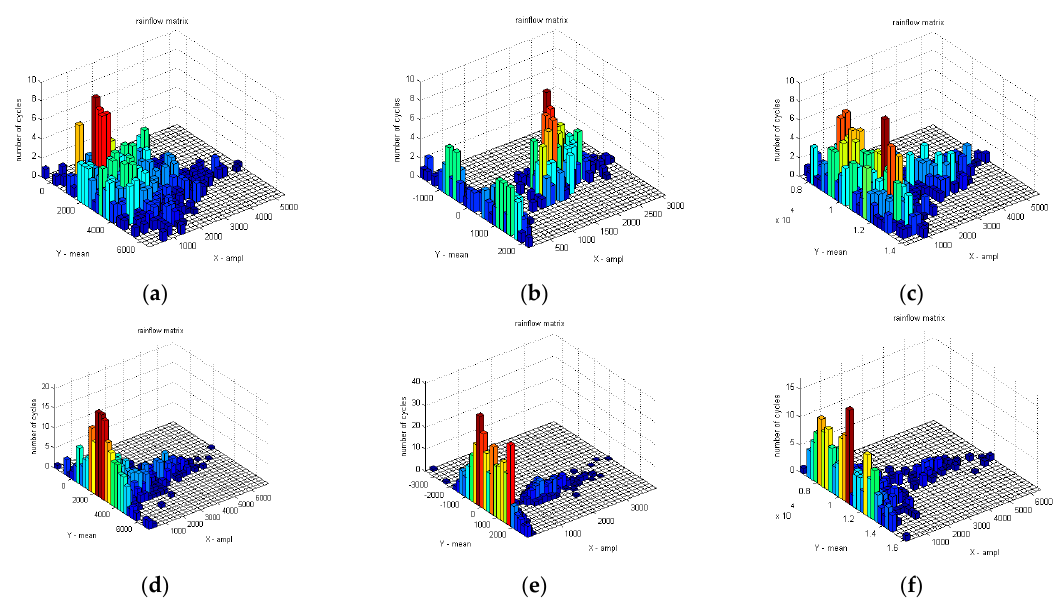
Figure 9. Rain flow matrix of load on the standard road. ( a ) Rain flow matrix of F x on the left WFS, ( b ) Rain flow matrix of F y on the left WFS, ( c ) Rain flow matrix of F z on the left WFS, ( d ) Rain flow matrix of F x on the right WFS, ( e ) Rain flow matrix of F y on the right WFS, ( f ) Rain flow matrix of F z on the right WFS. Sensors 2018 , 18 , x